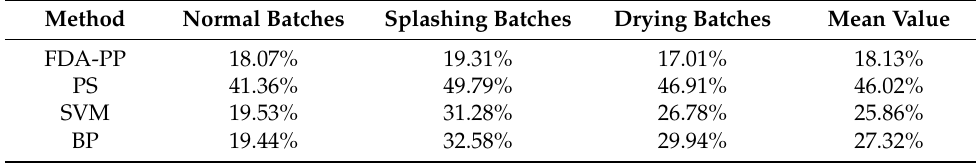
Table 3. MRPE of end-point time